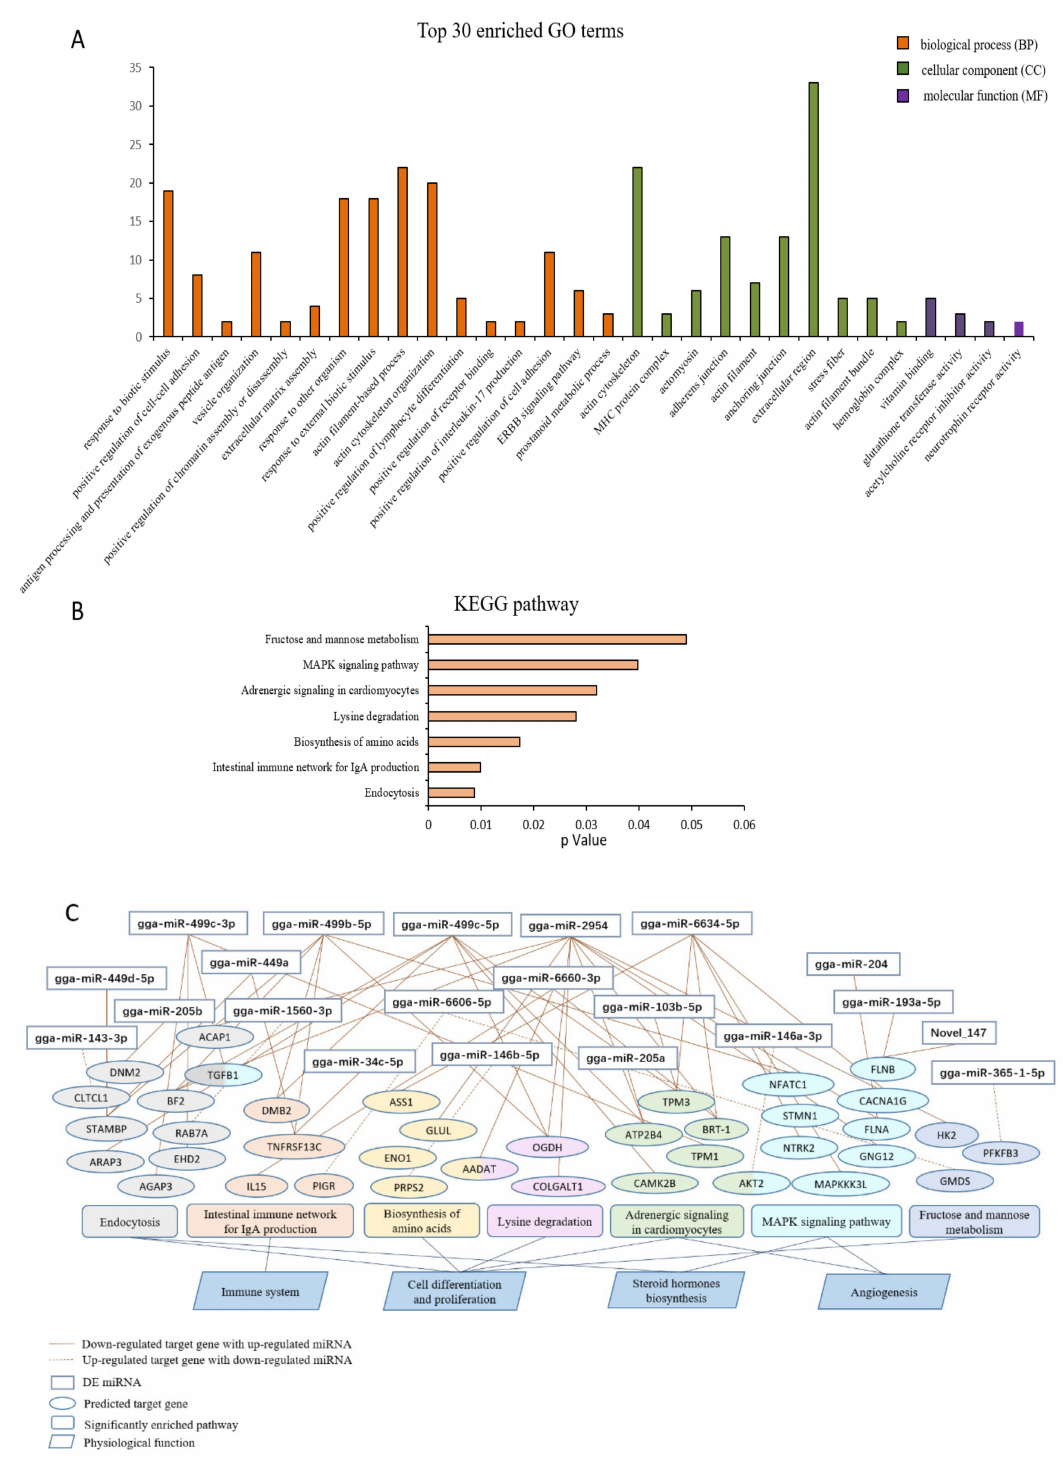
Figure 3. Functional enrichment analysis for DE miRNAs-DEGs. ( A ) The top 30 gene ontology (GO) terms from the GO enrichment analysis of the predicted target genes. ( B ) The Kyoto Encyclopedia of Genes and Genomes (KEGG) pathway significant enrichment analysis of predicted target genes. ( C ) The potential correlation network of